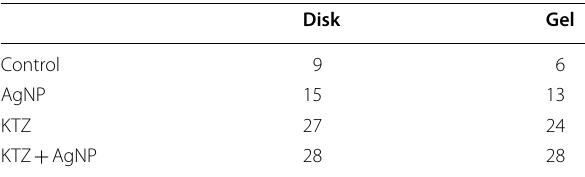
Fig. 2 Visualization of interaction between AgNP and M. furfur CBS 7019 by SEM. The black arrows show the interaction of AgNP on the surface of Malassezia yeasts